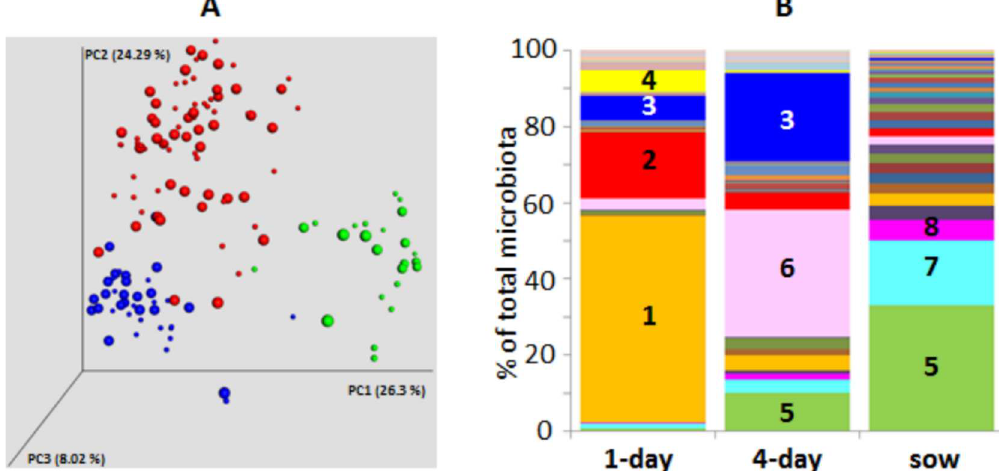
Fig 1. Microbiota composition in sows, 1- and 4-day-old piglets. Panel A, weightedPCoA analysisof microbiotacompositionin sows (blue spots), 1-day-old piglets(green spots) and 4-day-oldpiglets (red spots). Smaller spots–microbiotaof sows kept under conventional conditions with slatted floor, or of piglets deliveredby these sows. Bigger spots—microbiota of sows kept in enrichedpens with floor coveredwith straw bedding,or of pigletsdeliveredby these sows. Panel B, composition of fecal microbiotaof 1-day-old piglets, 4-day-oldpigletsand sows at the time of farrow 1— Escherichia , 2 – Clostridium , 3— Fusobacterium , 4— Actinobacillus ,5— Prevotella , 6 – Bacteroides , 7— Oscillospira ,8— Ruminococcus . For all genera, see S1